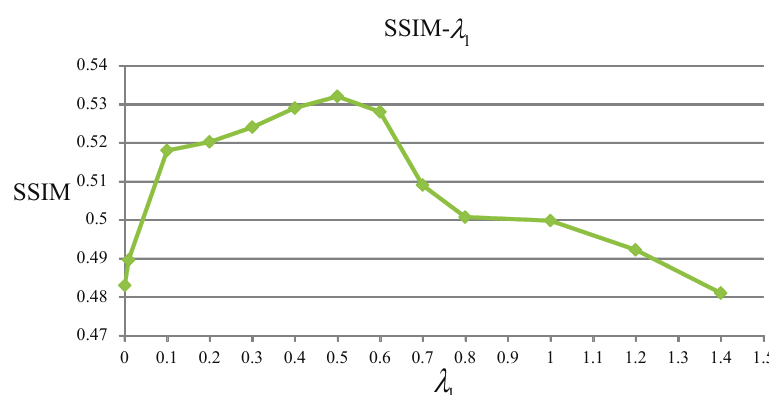
Figure 7. SSIM values with different λ 1 on the experiments.